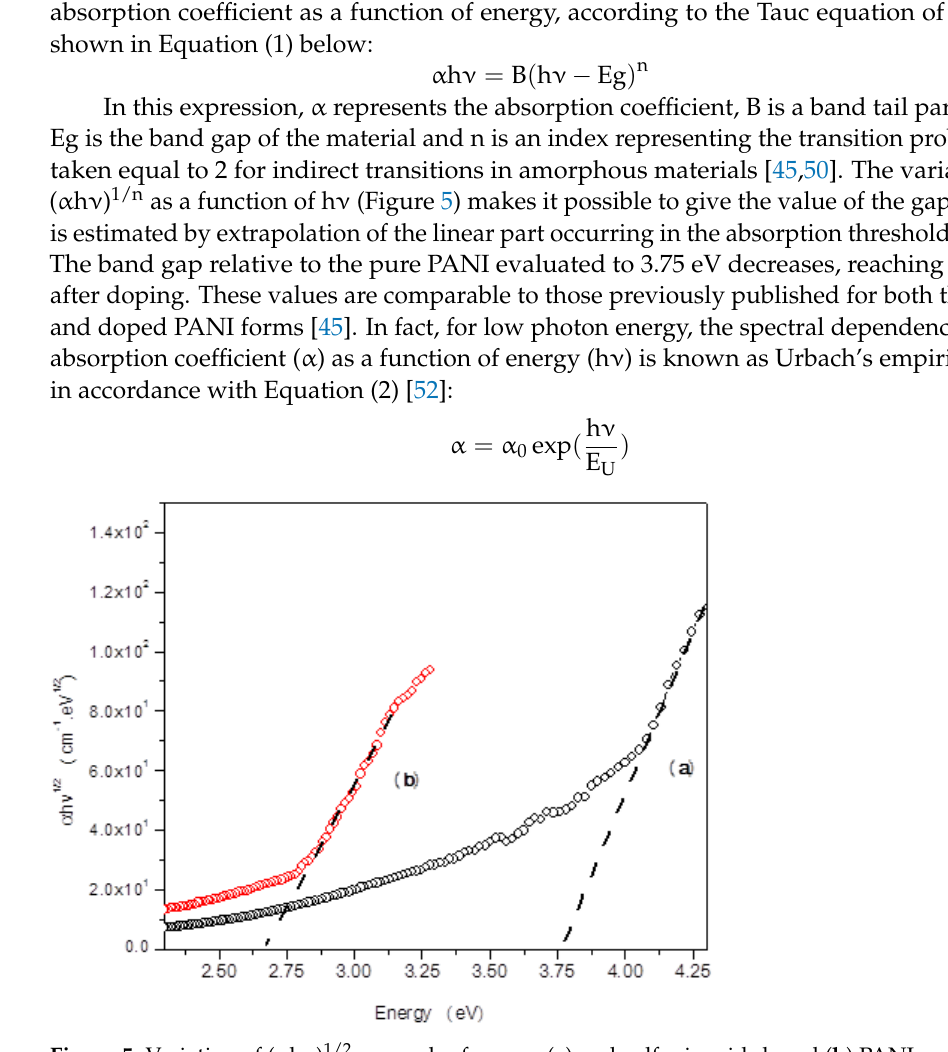
Figure 5. Variation of ( α h ν ) 1/2 versus h ν for pure ( a ) and sulfonic acid-doped ( b ) PANI.